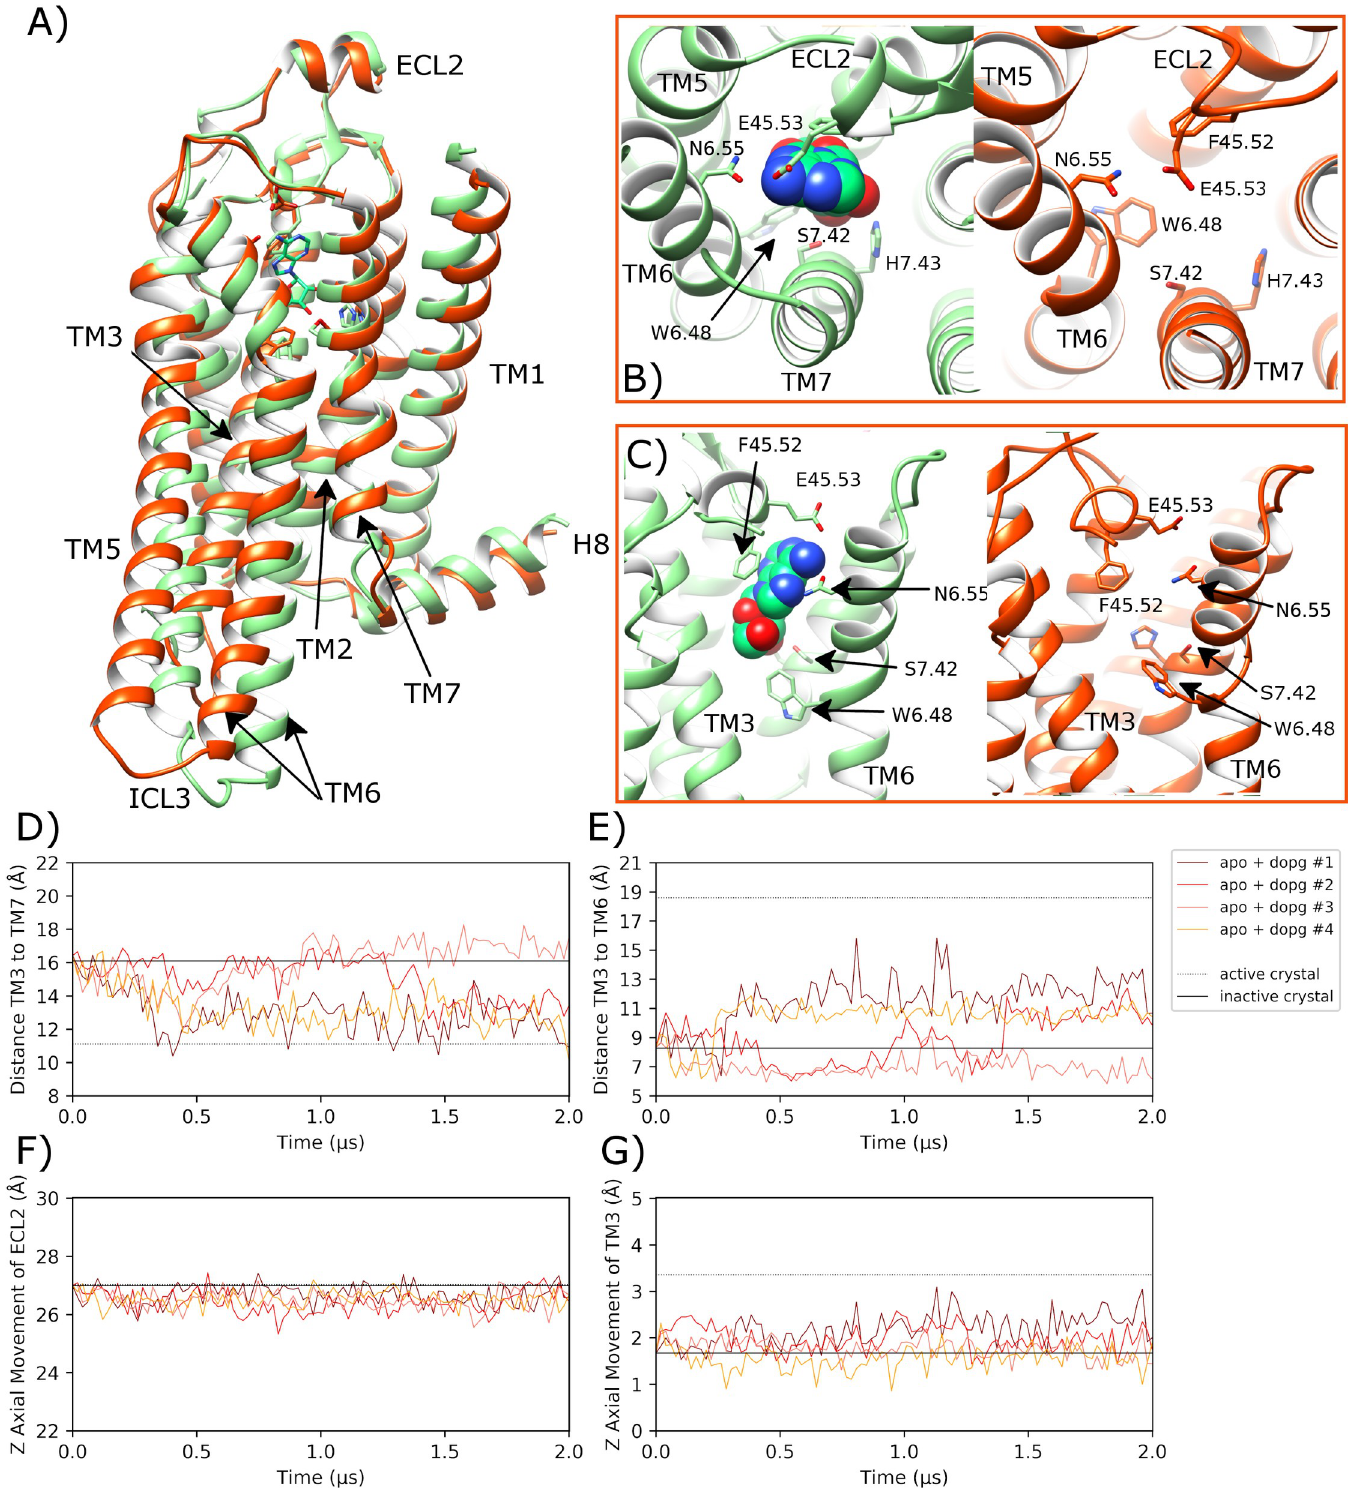
Fig 5. Transition towards an alternative intermediate conformation of apo A2aR in a DOPG membrane. A) Comparison of the intermediate state crystal structure of A2aR (PDB entry: 2YDO, light green) with bound adenosine and an MD-generated apo conformation achieved within a DOPG membrane (orange, belonging to replica #1 from 1.6 μ s), showing B) and C) selected residues delineating the orthosteric pocket. ECL2 and TM helices are labelled where applicable. D) Distance between